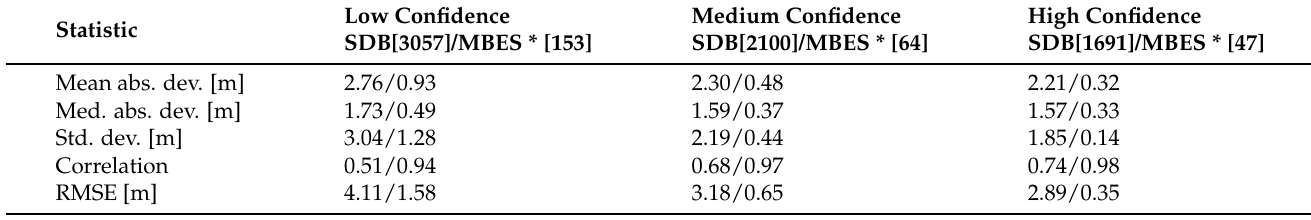
Table 4. Statistics for the comparisons of ICESat-2 derived bathymetry around Sisimiut. * For comparison with MBES the obvious misinterpretations of the ICESat-2 algorithm were removed. The values in parentheses show the number of data points used for the statistics.